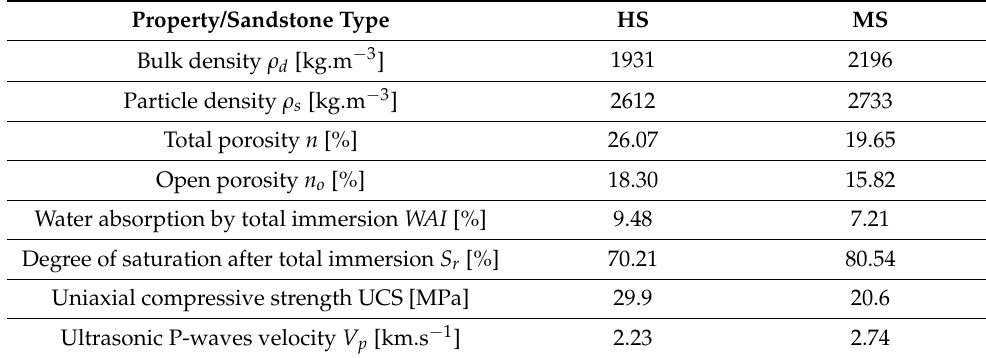
Table 2. Basic physical properties of studied sandstones—mean